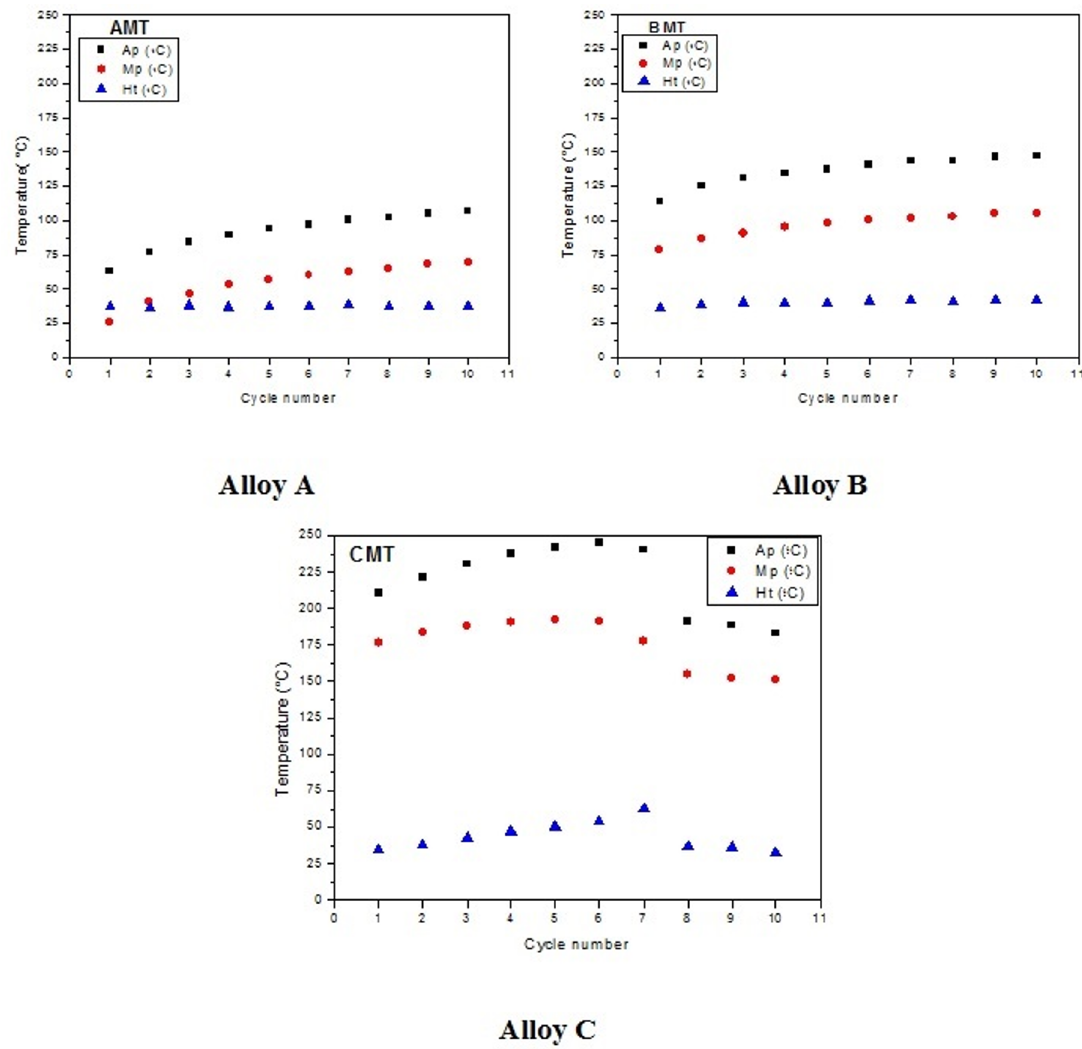
Figure 3. Evolution of the peak temperatures of the transformations and hysteresis during thermal cycling of the Cu-Al-Ni alloys (modified and